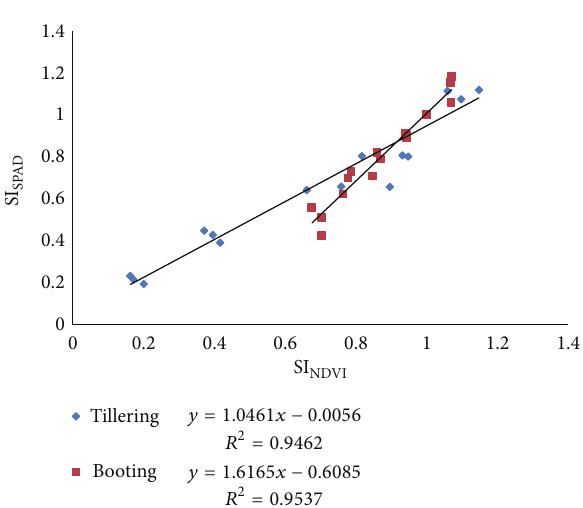
Figure 5: Relationship between relative variation in sensor deter- minedvegetationindex(SI NDVI )andvariationinrelativechlorophyll meter (SI SPAD ) readings for data collected during tillering and booting stages.